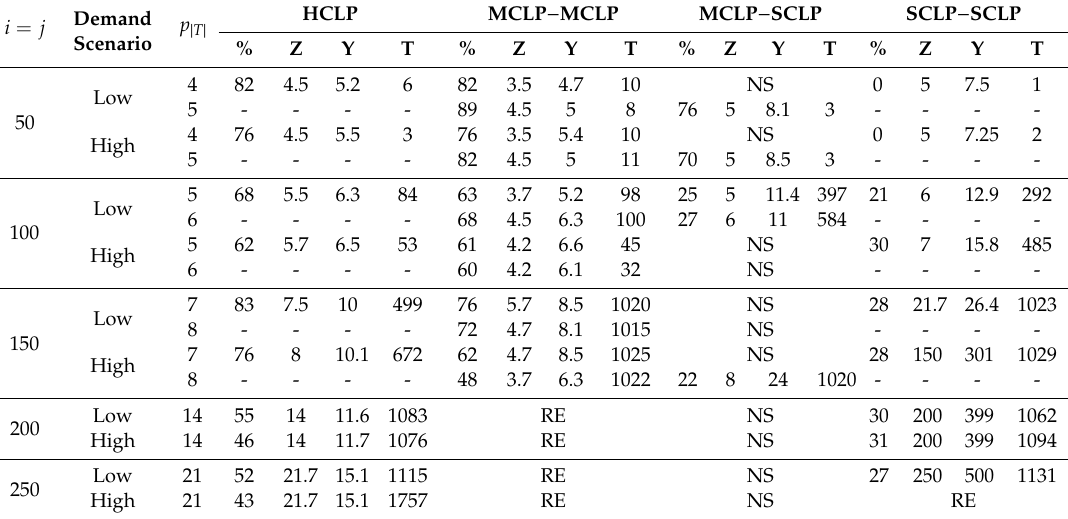
Table 7. Computational results to compare di ff erent variants for four